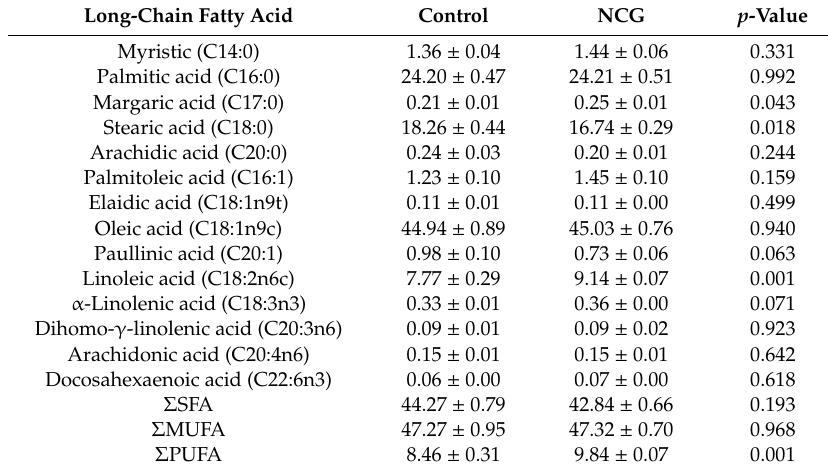
Table 7. E ff ect of dietary N -carbamylglutamate on long-chain fatty acid composition (% of total fatty acids) in the perirenal adipose of Ningxiang